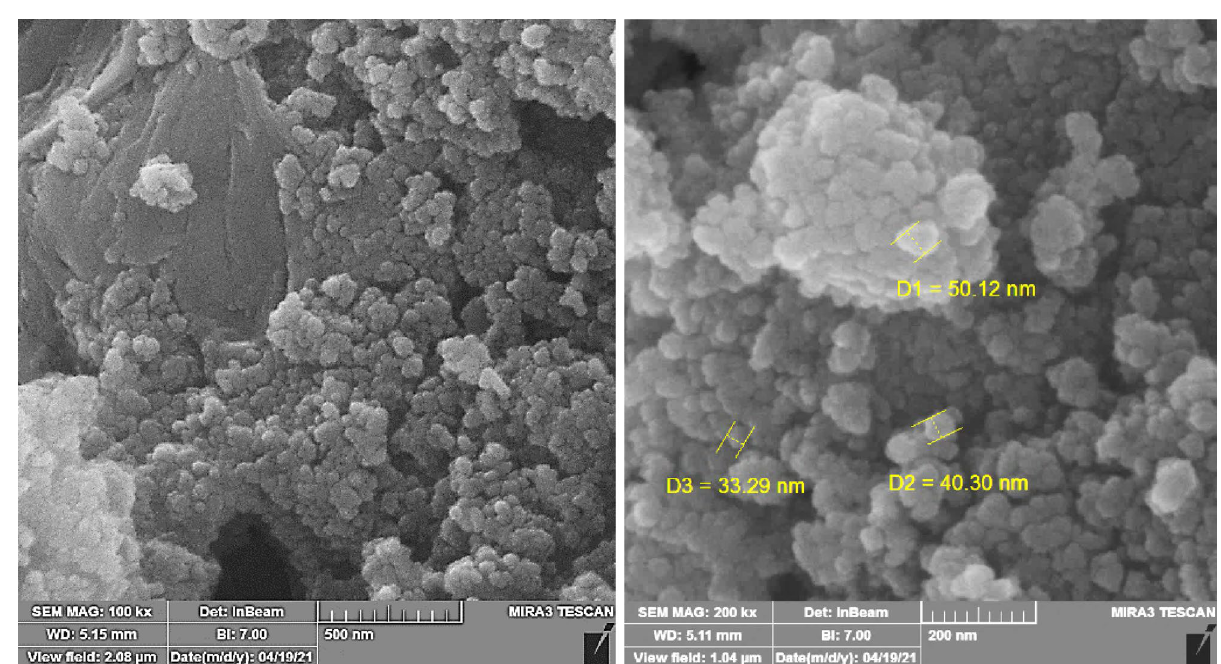
Figure 4. FE–SEM image of biochar/Fe 3 O 4 /PVIm/Ag